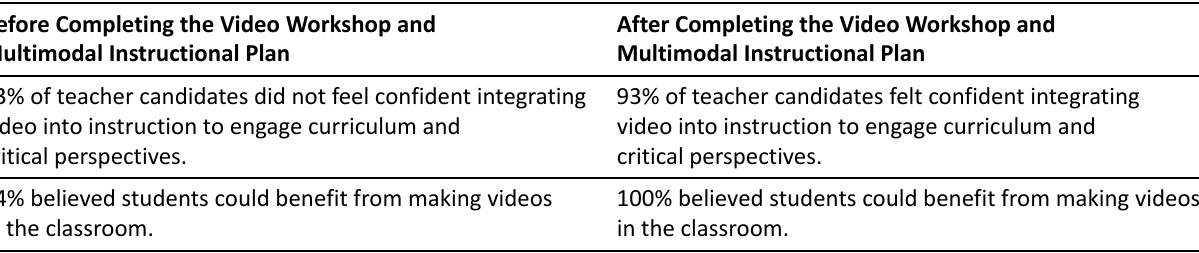
Table 2. Teacher candidate attitudes to video production in the elementary classroom before and after designing a multi- modal instructional